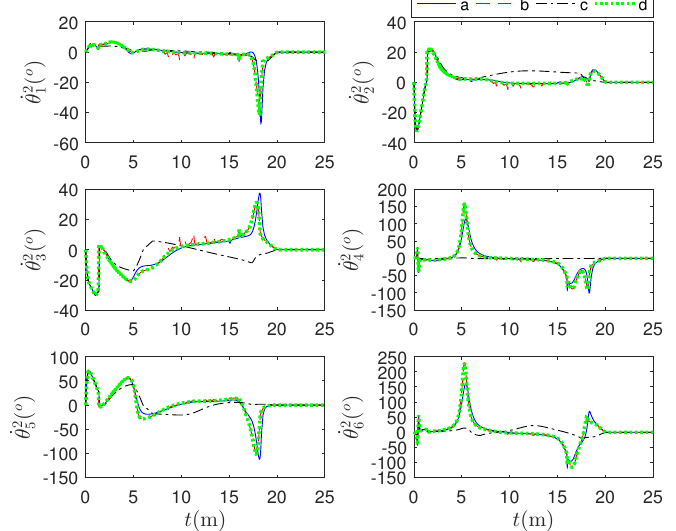
Figure 9. The joint angular velocity of balance arm in four